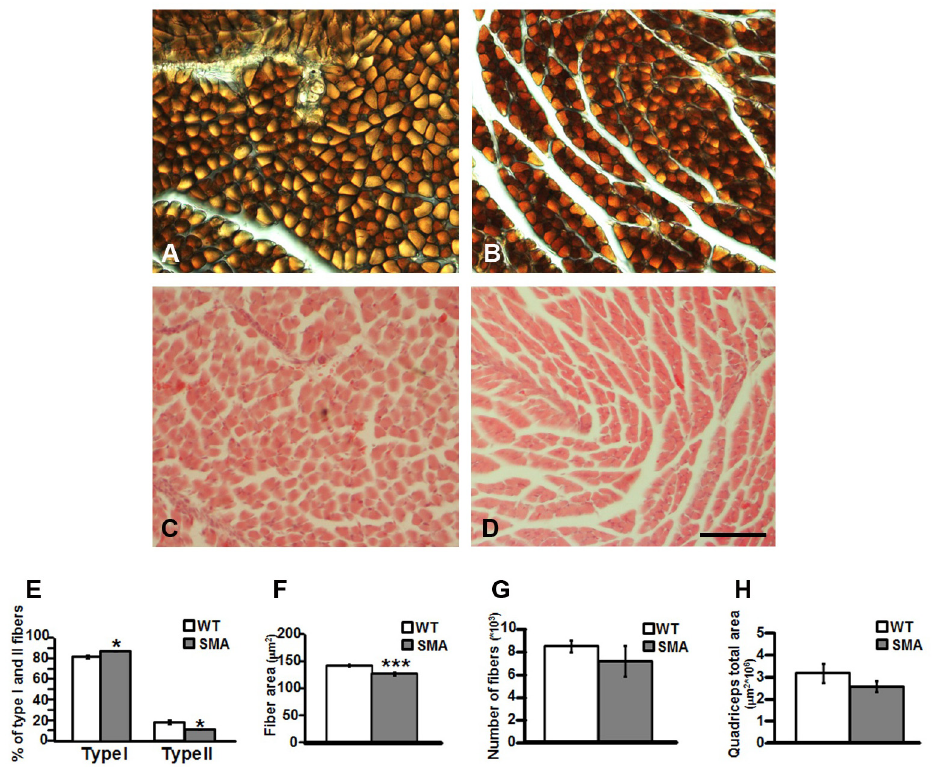
Fig 1. Fiber morphology of the quadriceps in WT and SMA mice at P10. Panels A-B, Cox immunoreaction on quadriceps of WT (panel A) and SMA (panel B) mice, revealing the mitochondrial activity and the fiber types. Scale bar = 40 μ m. Panels C-D showed the same muscles (WT: panel C; SMA: panel D) stained by hematoxylin/eosin. Scale bar = 80 μ m. Panel E, quantification of fiber type I and II in quadriceps of WT and SMA mice, expressed as percentage of the total number of fibers. Panels F-H, respectively single fiber area, number of fibers and total area of quadriceps in WT and SMA mice. * p < 0.05; *** p < 0.001 by t-test